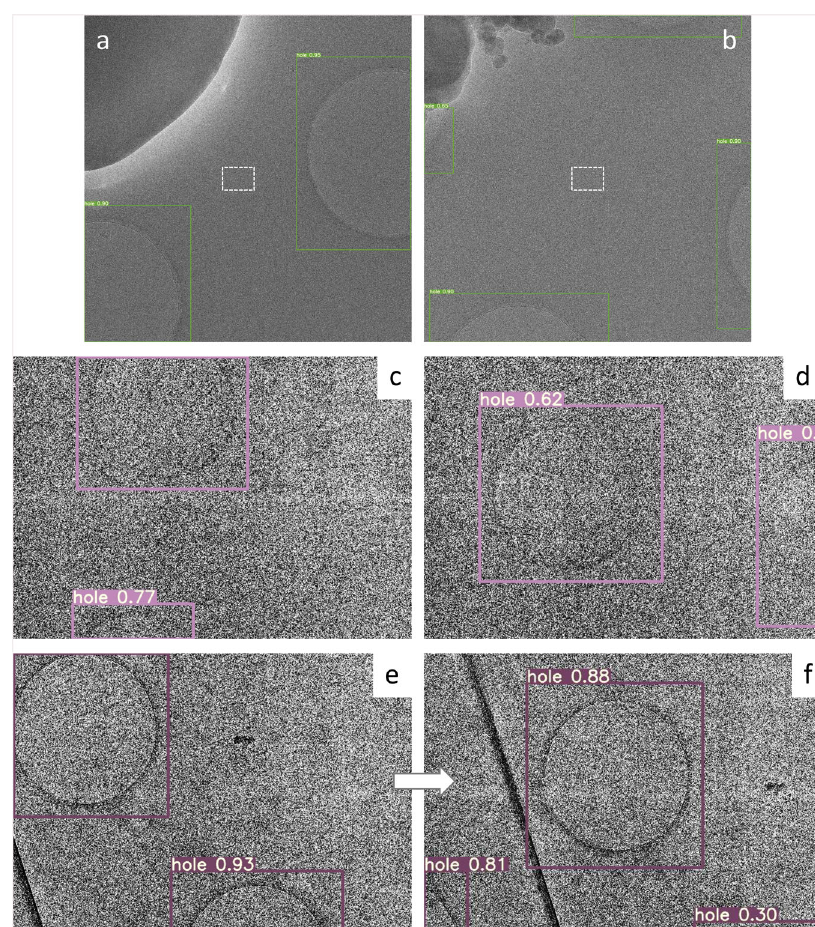
Fig. 3 Detection of carbon holes. a , b Failures of stage positioning were done by cross-correlation with a reference image using SerialEM due to excessive contamination in dark blobs and to partially recorded multiple holes. Center small rectangles (white broken lines) indicate a rough position and dimension of acquired movie stacks on the K3 camera at a nominal magni fi cation of 100,000×. The horizontal size of the rectangles corresponds to ~0.28 μ m. Thus, each of these alignments produced 25 useless image stacks, as image shifts were applied over 5 × 5 neighboring holes for data collection at that time. YOLOv5 with a weight trained in this study detected all holes (boxes) correctly. c , d Low-contrast images of holes covered with a thin carbon layer and with thick ice. The trained weight still succeeded in hole detection (boxes). e The fi rst image taken in search mode. f The second image after stage adjustment by yoneoLocrWatch.py running in hole mode and